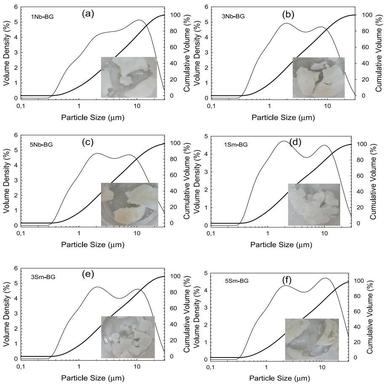
Particle size distribution graphs of the as-prepared bioactive glass powders (a) 1Nb-BG, (b) 3Nb-BG, (c) 5Nb-BG, (d) 1Sm-BG, (e) 3Sm-BG, (f) 5Sm-BG. Images of the related bioactive glasses after drying at 60 ◦C for 24 h.